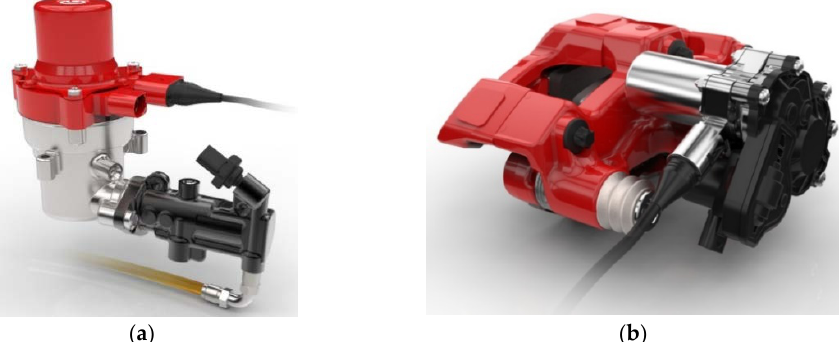
Figure 1. Brake-by-wire actuators: ( a ) electro-hydraulic actuator for standard brake caliper; ( b ) electromechanical brake caliper [2].